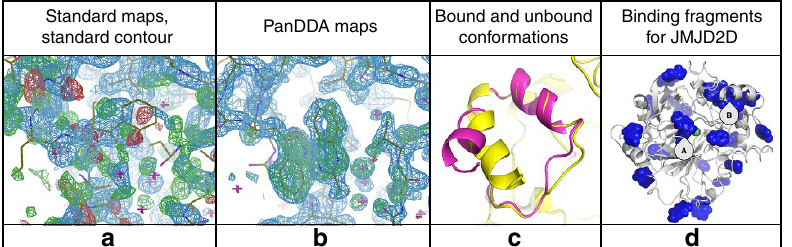
Figure 4 | PanDDA maps reveal complex minor conformations and identify allosteric binders. In JMJD2D data set x402, at 1.45Å, ( a ) conventional maps (contoured as in Fig. 3a) show a complex superposition of bound and unbound states that make it impossible to identify the bound state (the known unbound state is shown). ( b ) However, in PanDDA maps (contoured as in Fig. 3c, BDC ¼ 0.8) the bound conformation can be modelled easily (as shown). ( c ) Final models for the unbound (yellow) and bound (magenta) conformations highlight the large conformational change. ( d ) Fragments are detected to bind all over the surface of JMJD2D, revealing potential allosteric sites, including the peptide-binding groove (site A) and the large helix reordering (site